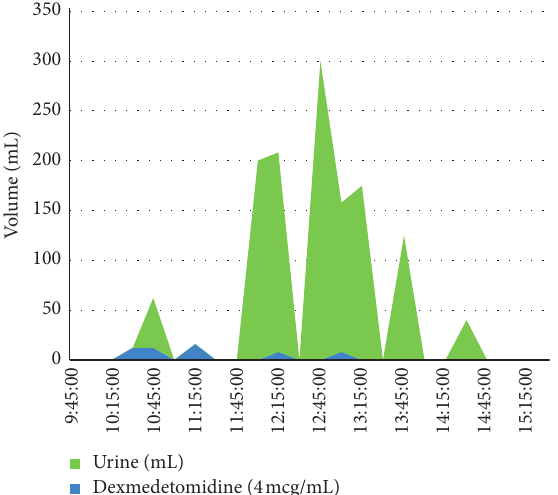
Figure 1: Dexmedetomidine effect on urine output over time. The correlation between dexmedetomidine boli and urine output is shown. Volumes of both urine and dexmedetomidine are shown. Dexmedetomidine volumes are also listed in the